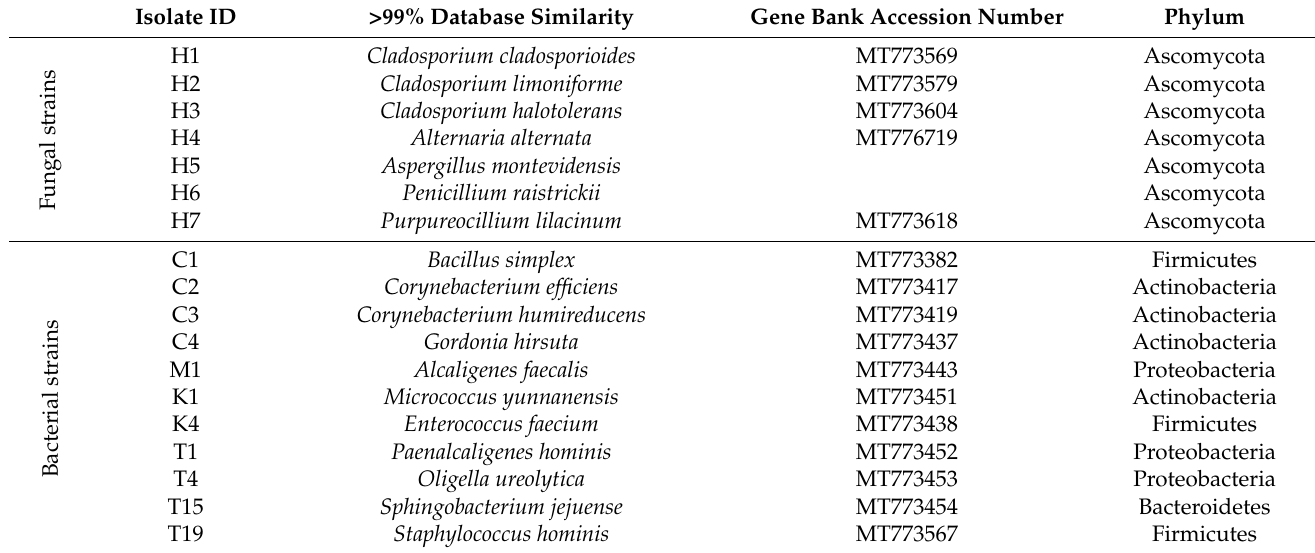
Table 2. Identified isolated microorganisms according to the 99% of database similarity, Gene bank ascension